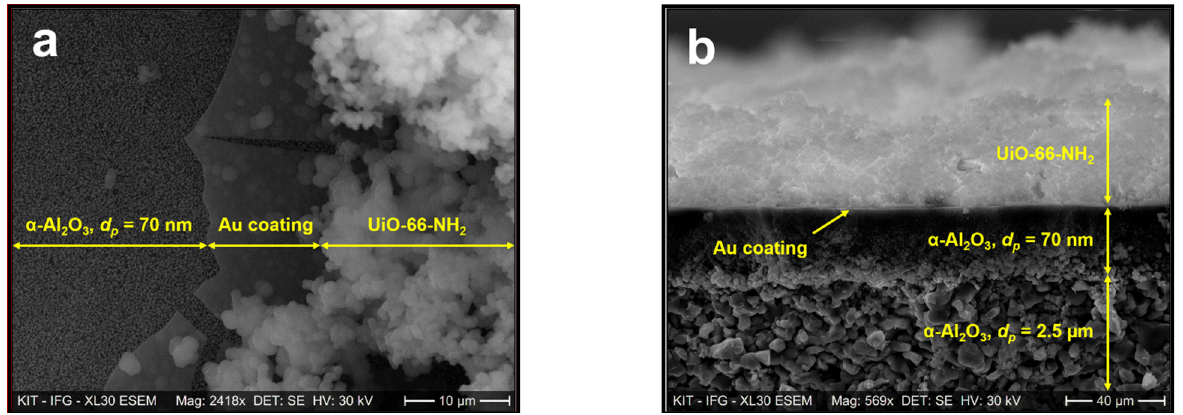
Figure 4. SEM images of ( a ) the top surface and ( b ) the cross-section of the U-LBL